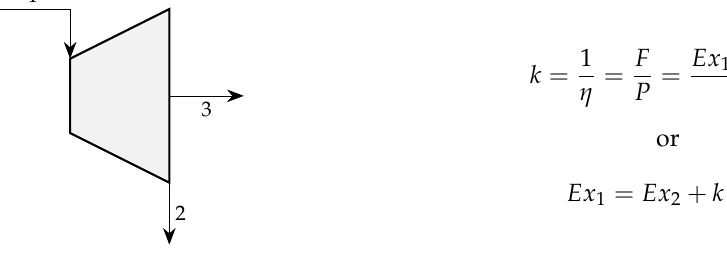
Figure 2. Conventional efficiency definition of a turbine, as an example of the Rule F